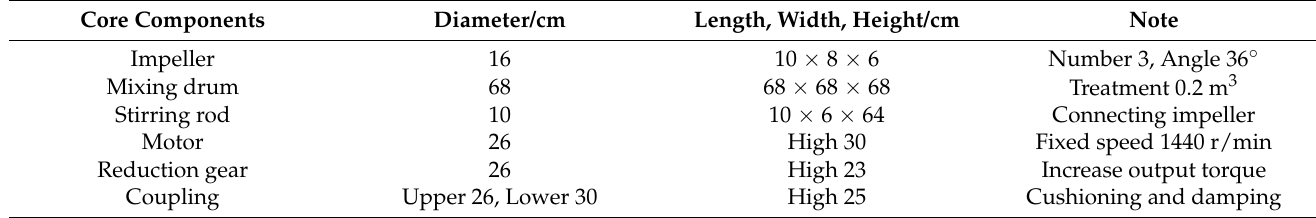
Table 12. Main component parameters of D680 mixing